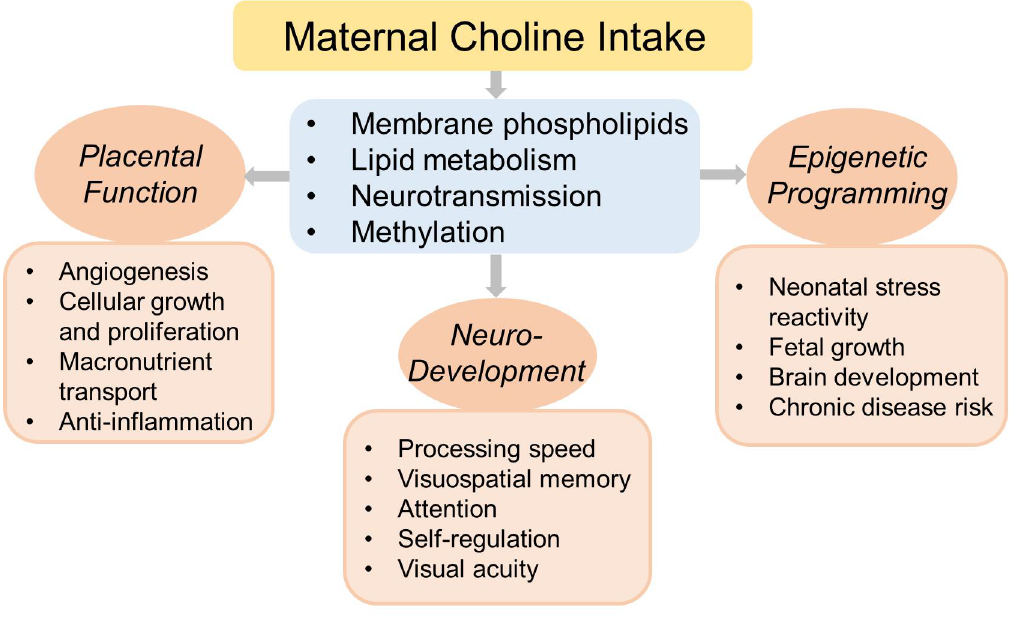
Figure 2. An overview of the e ff ects of maternal choline intake during pregnancy on physiological processes and health